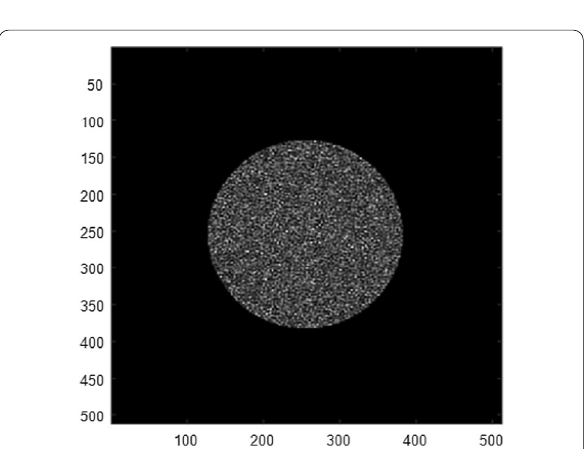
Fig. 7 The FT corresponding to the multiplication of the modulated speckle shown and the 1st objective of the microscope shown in Fig. 6. The formed pattern which is the diffuser image convoluted with the PSF corresponding to the 1st objective located in the object